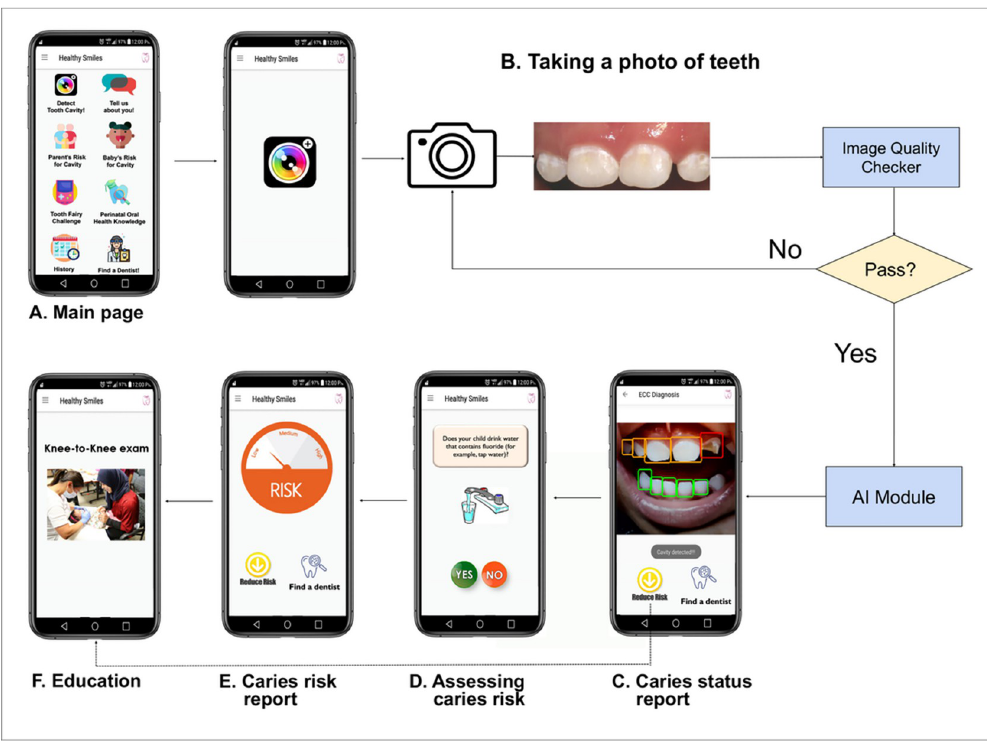
Fig 1. AICaries smartphone app functional flow. A. AICaries app main page. B. To attract app use, users will start with taking teeth photos for caries detection assessment. The teeth photo will go through an Image Quality Checker. Image that passes quality check will get to the next step, “AI-Powered caries detection”. If the image fails the quality check, the app will instruct users to retake teeth photos until desired quality is achieved. C. The app will then generate a Caries Status Report for each tooth. On the Caries Status Report interface, users will make choices for the next step, such as Assess Caries Risk (D) using a previously developed risk assessment system. Users will receive their caries risk as Low, Medium, or High (E). On